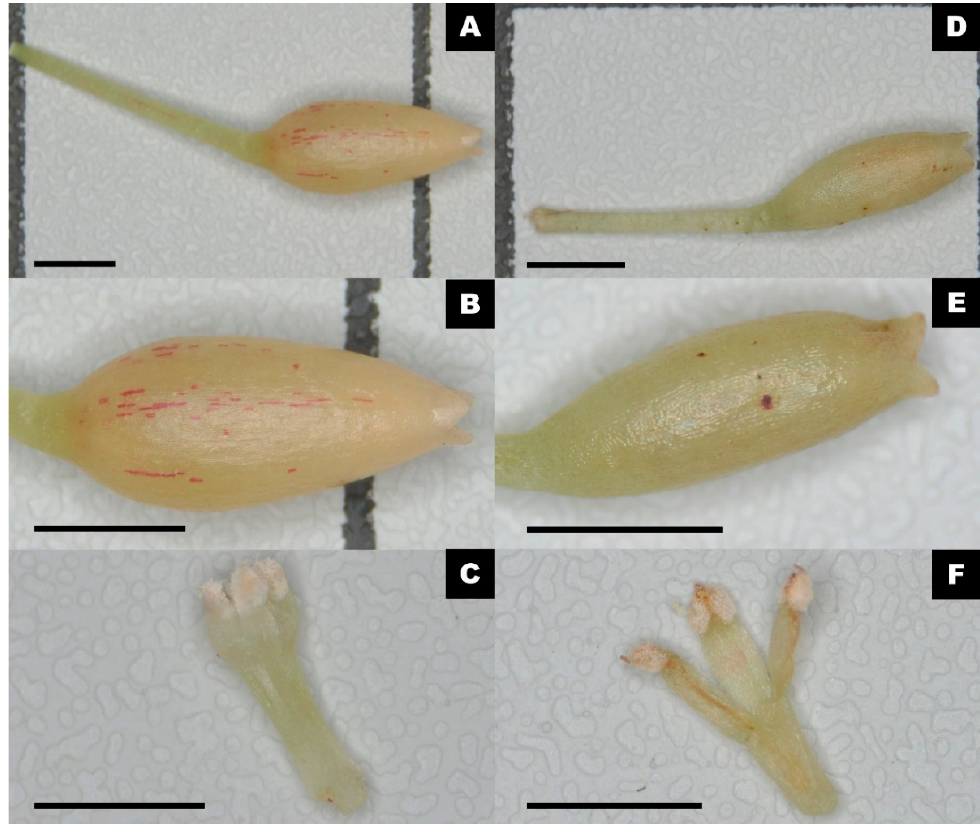
Figure 10. Floral dissection of Heterosmilax gaudichaudiana (Kunth) Maxim. and Heterosmilax japonica Kunth. ( A – C ), H. gaudichaudiana , ( D – F ), and H. japonica . ( A , D ); Flowers including the pedicle (scale bar = 0.2 cm). ( B , E ) Corolla (scale bar = 0.2 cm). ( C , F ) Stamen (scale bar = 0.1 cm). The filament of H. gaudichaudiana is nearly fused for its full length as a single column, while the filament of H. japonica is fused at its lower